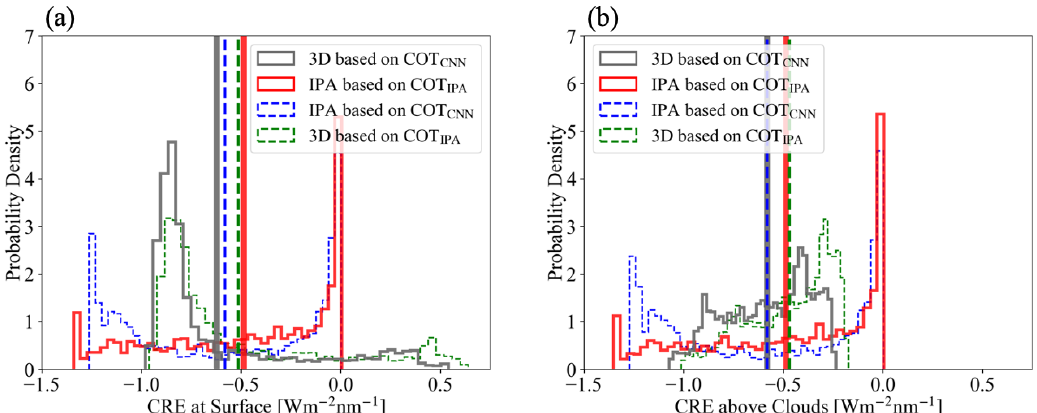
Figure 14. Histograms of cloud radiative effects derived from 3D irradiance calculations based on COT CNN (solid gray), IPA irradiance calculations based on COT IPA (solid red), IPA irradiance calculations based on COT CNN (dashed blue), and 3D irradiance calculations based on COT IPA (dashed green) both (a) at the surface and (b) above the clouds. The mean values are indicated by vertical